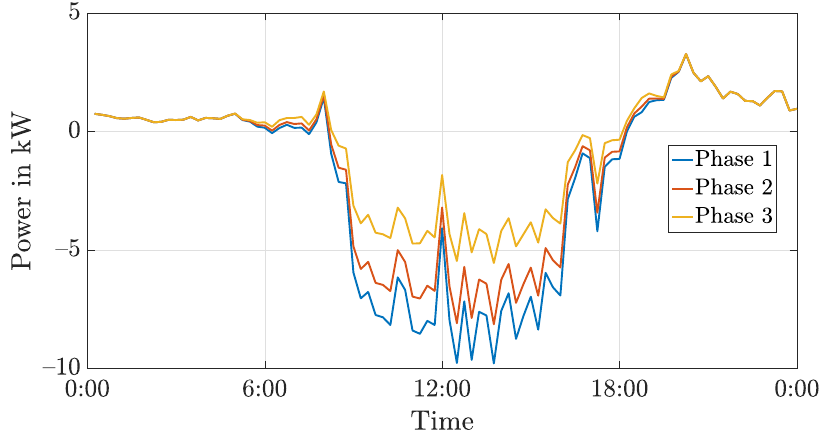
Figure 7. Total power import per phase.